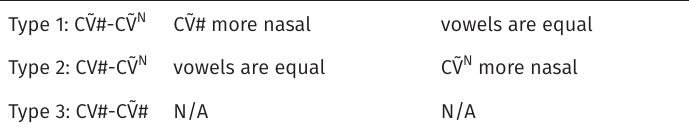
Table 4: Interpretation of